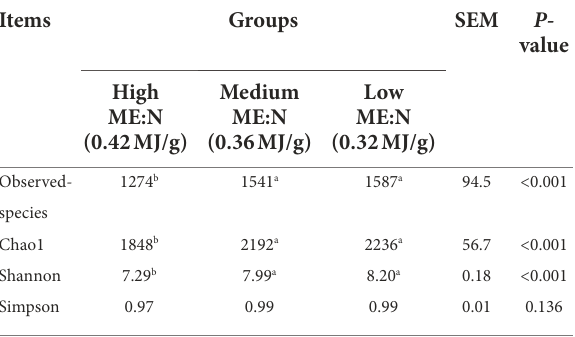
TABLE 5 Changes of different ME:N ratios on alpha diversity indices of rumen bacteria in yaks.